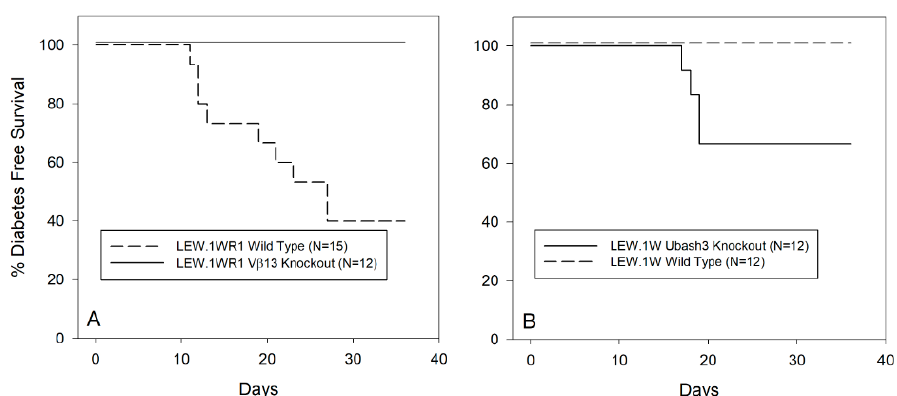
Figure 2. Panel ( A ). Frequency of diabetes in wild-type and V β 13S1A1 null/null LEW.1WR1 rats treated with poly I:C three times weekly as described in Methods. Rats deficient in V β 13 are completely resistant to induction of T1D compared to parental strain, LEW.1WR1 rats. The two survival curves are statistically significantly different ( p < 0.002). Panel ( B ). Frequency of diabetes in LEW.1W and LEW.1W Ubash3a null/null rats following treatment with poly I:C three times weekly as described in